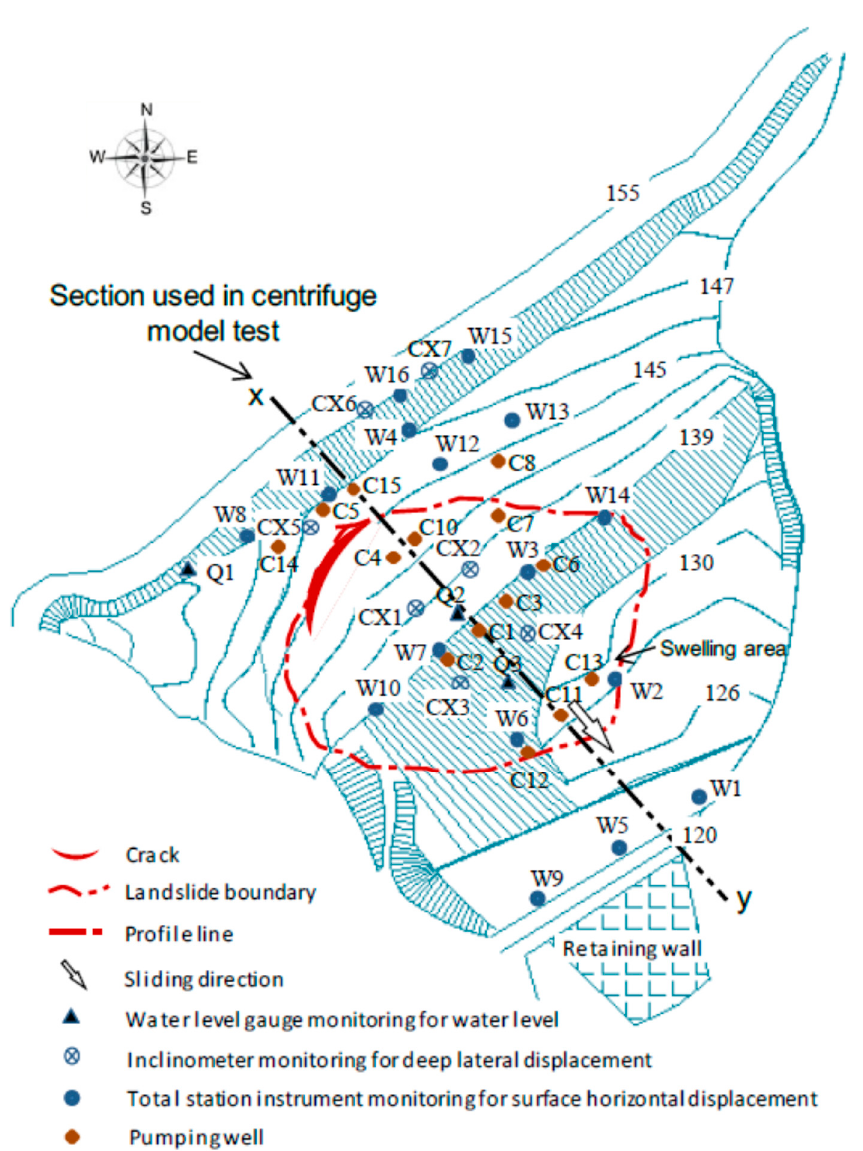
Figure 2. Site plan of monitoring points and pumping wells.